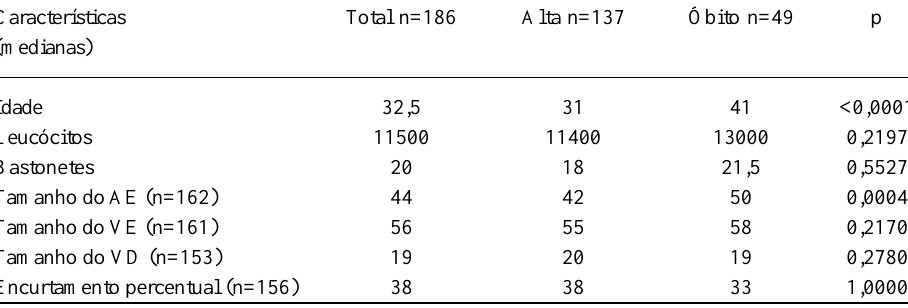
Tabela 2. Mortalidade em análise univariada de variáveis contínuas.